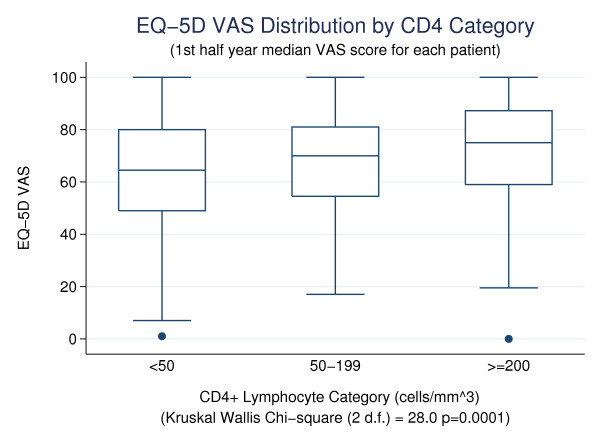
EQ-5D VAS Distribution by CD4 Category (1st half year median VAS score for each patient).